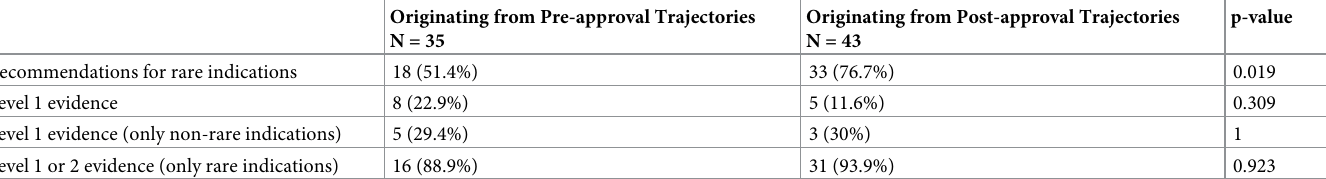
Table 3. Specific NCCN off-label